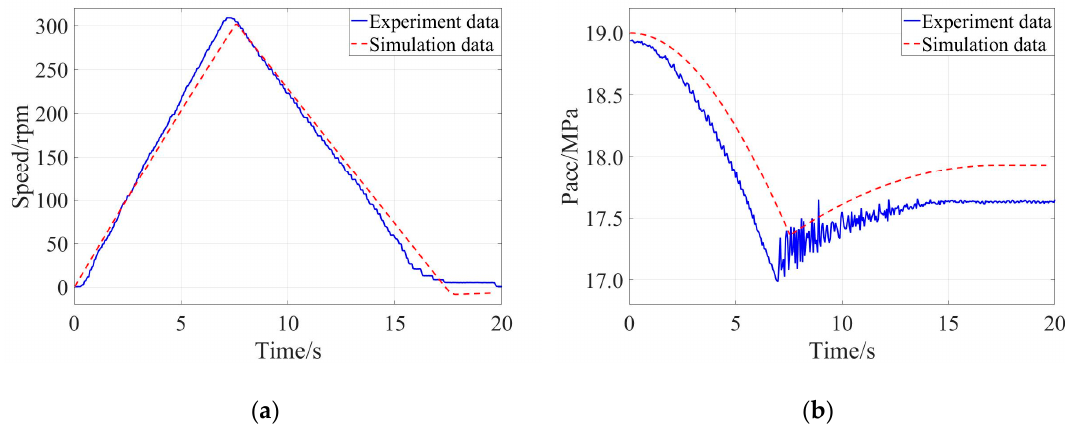
Figure 9. Comparison of the experimental result and the simulation result when the braking intensity was 0.30: ( a ) Evolution of speed of the flywheel, ( b ) Evolution of pressure of the accumulator.